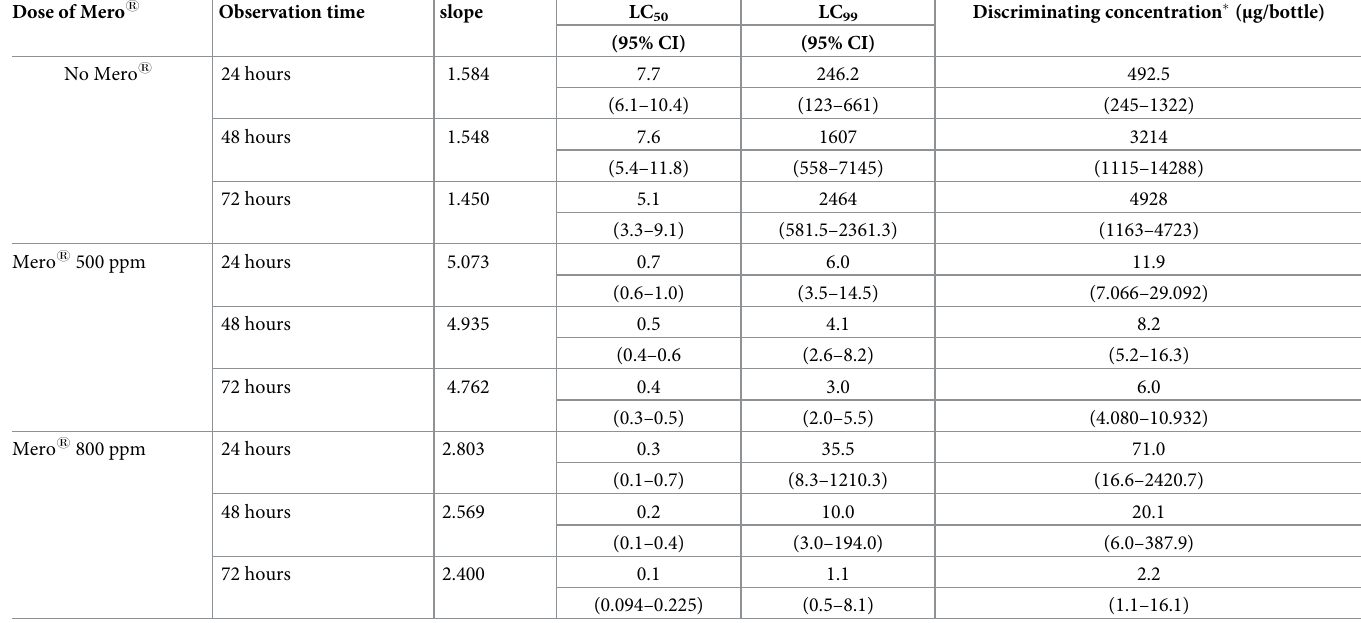
Table 1. Lethal concentrations (LC 50 and LC 99 ) and discriminating concentrations of broflanilide against insecticide susceptible An . gambiae s.s. Kisumu in bottle bioassays with and without Mero 1 adjuvant. Probit analysis was performed using SPSS software . Dose of Mero